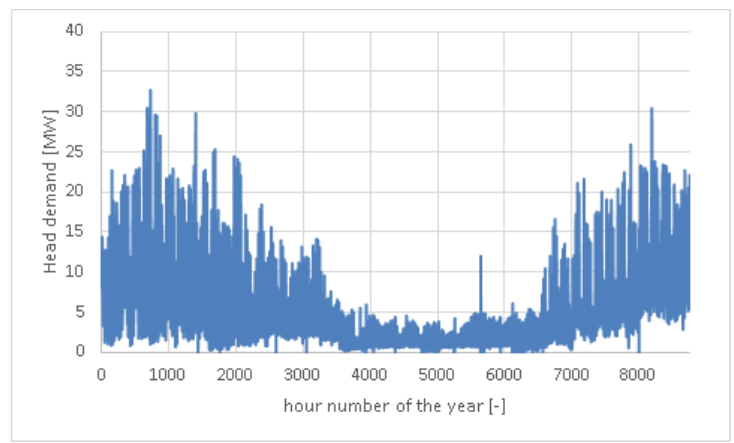
Figure 2. Hourly consumption of the studied District Heating Network in